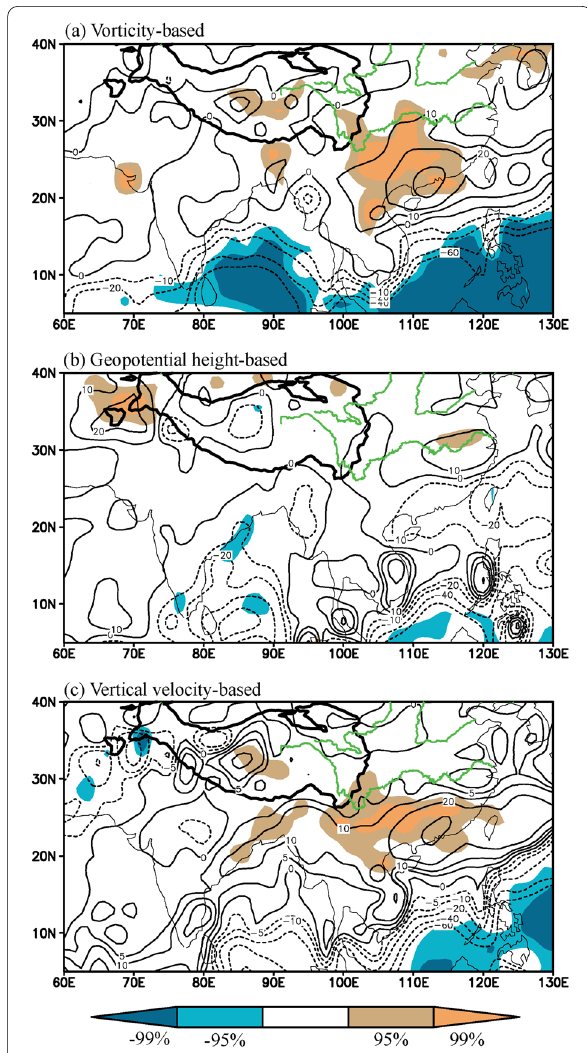
Fig. 10 Anomalous precipitation (units: mm) regressed upon the ( a ) vorticity‑based, ( b) geopotential height‑based, and ( c) vertical velocity‑based IBT indices in winter for the period 1979–2019. Shadings denote positive/negative precipitation anomalies significant at the 95% and 99% confidence levels as shown by the color bars. The vorticity‑based IBT index is defined as